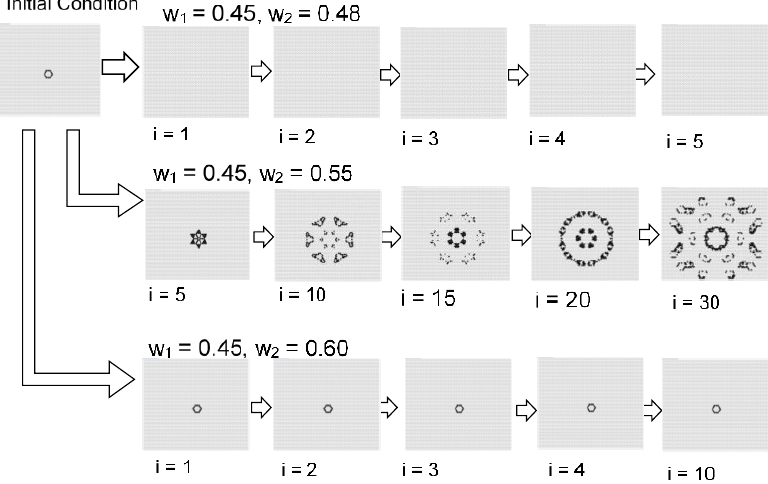
Figure 18. Results for the model with s = 5 and t = 8 in a hexagonal grid. The initial pattern was a deformed ring with a thick upper boundary. When w 1 = 0.45 and w 2 = 0.65, the ring pattern was divided while moving. When w 1 = 0.45 and w 2 = 0.72, a moving ring-like pattern formed. When w 1 = 0.45 and w 2 = 0.75, a single fixed symmetrical ring pattern formed.